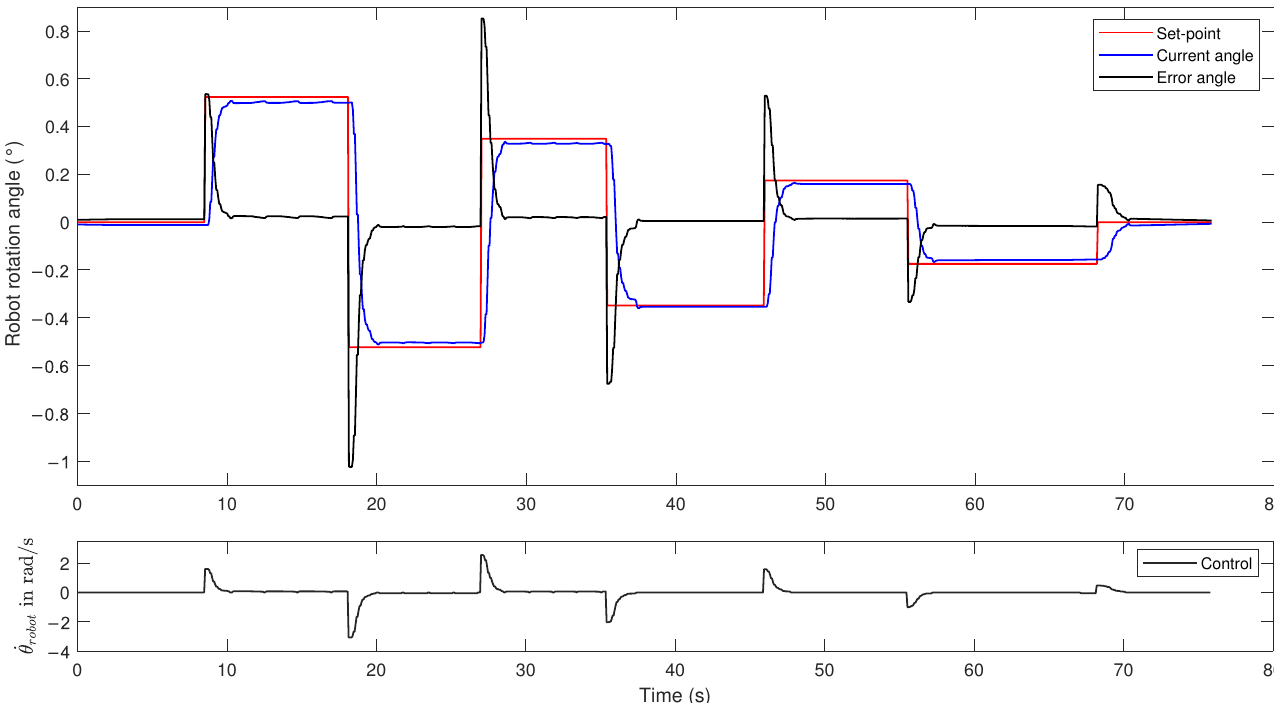
Figure 7. Robot’s behavior with the lane-keeping controller. The figure shows seven set points emulated sequentially: ± 0.52, ± 0.35, ± 0.17, and 0